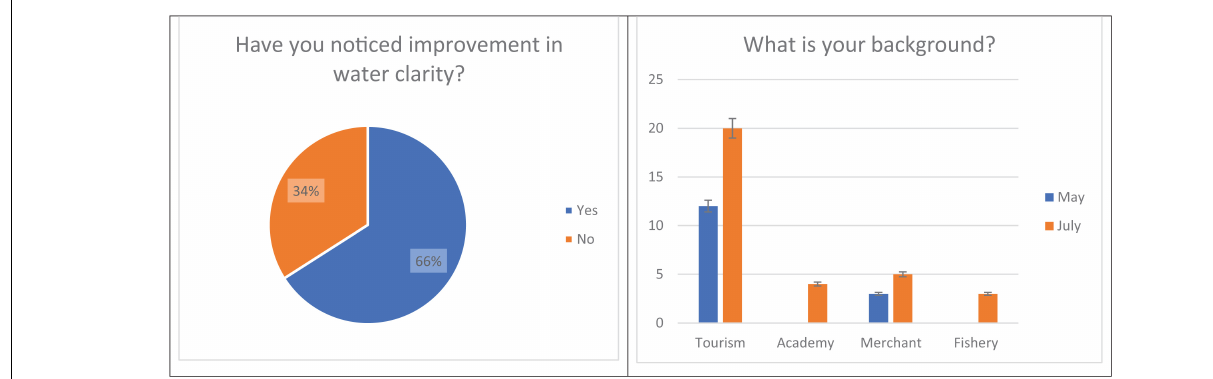
FIGURE 4 | Results from Galapagos.